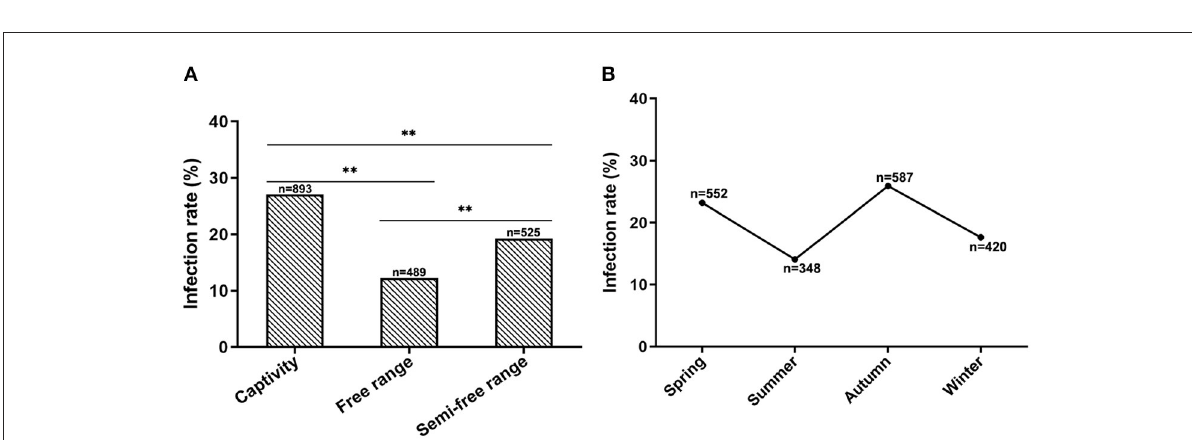
FIGURE5 Effect of feeding modes and seasons on CEV/OEV infection. (A) CEV/OEV infection rates in different feeding modes. CEV/OEV infection rates of different feeding modes were detected and comparatively analyzed. The CEV/OEV infection rate of goats/sheep in captivity was significantly higher than that of goats/sheep in free range and semi-free range, while higher infection rate of goats/sheep was observed in semi-free range than in free range. (B) CEV/OEV infection rates in four seasons. CEV/OEV infection rates of different seasons were comparatively analyzed. The infection rates were higher in spring and autumn than those in summer and winter. “n” represents the number of specimens detected. **Indicates highly significant difference ( P <